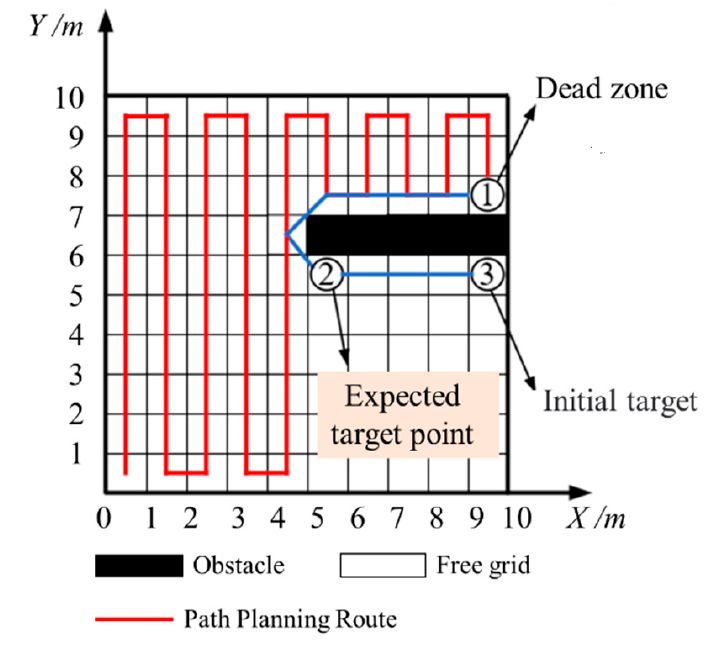
Figure 10. Dead zone escape